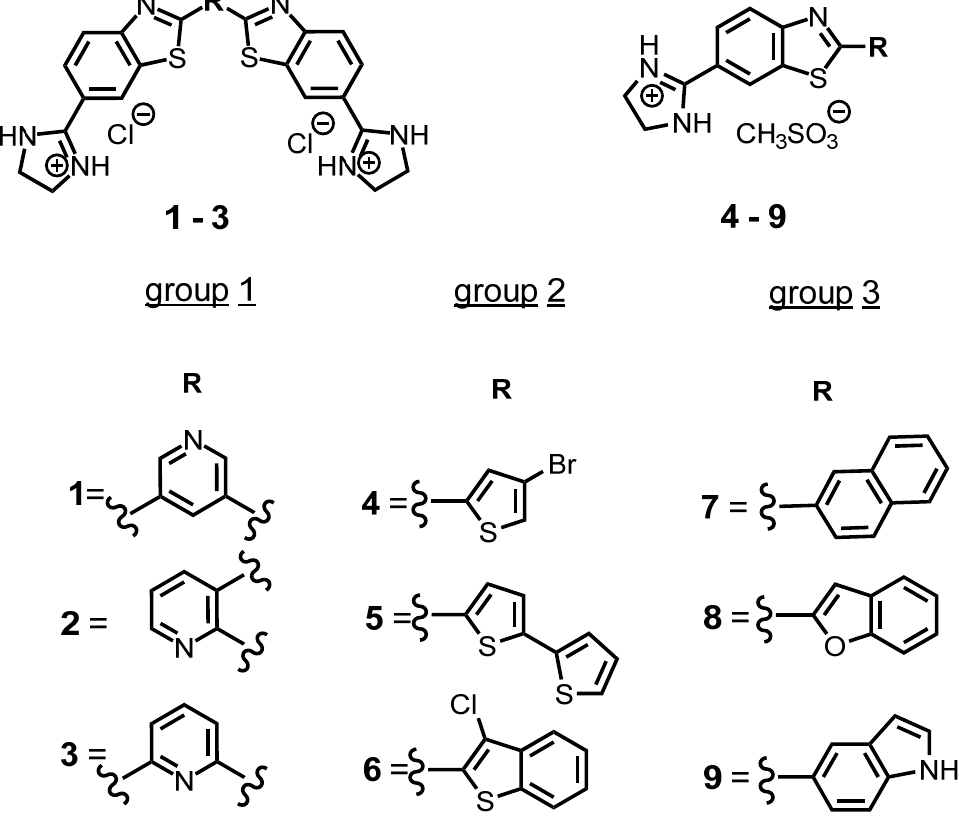
Table 1. Electronic absorption data a , absorption maxima, and fluorescence data of